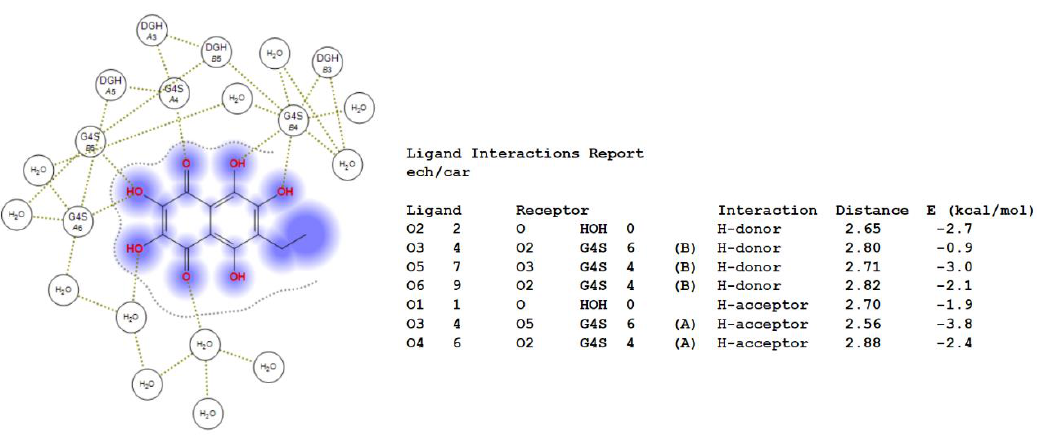
Figure 2. 2D-diagram of contacts of Ech with the κ -CRG in the binding site and table of Ech interac- tion contacts.